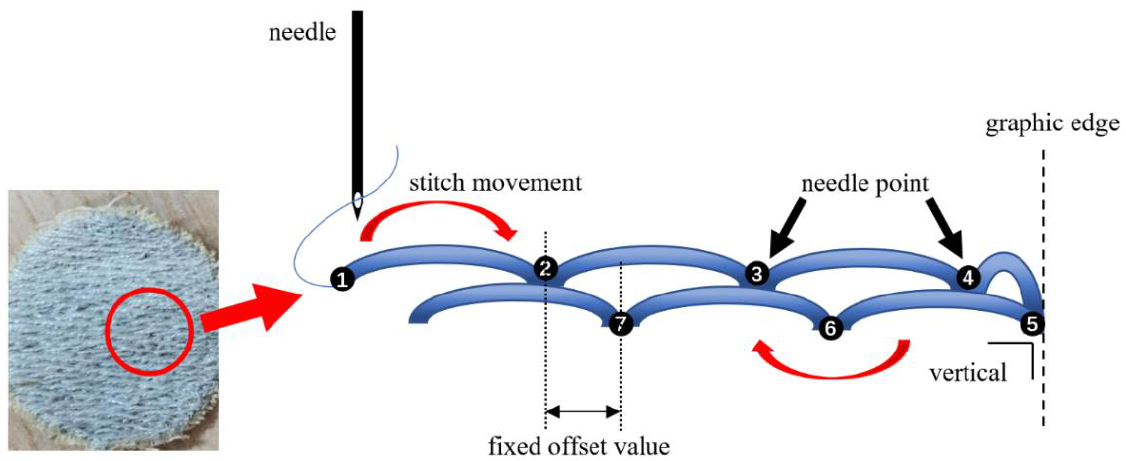
Figure 4. “Tatami” stitch analysis (Dots 1-7 indicate the sequence of needle drop).